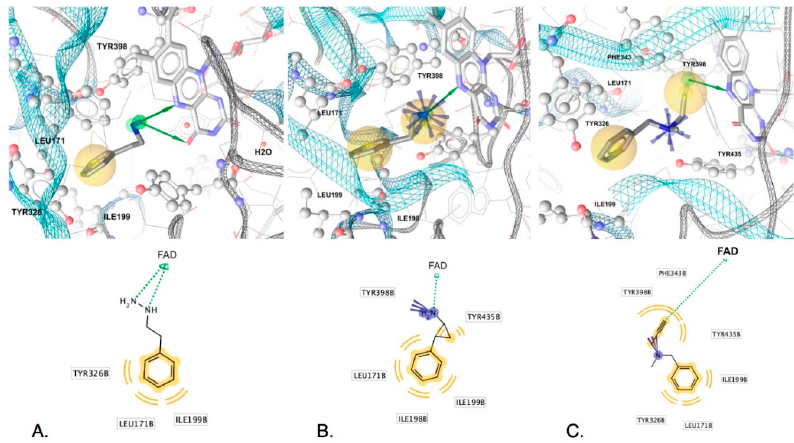
Figure 4. Non-covalent interactions of ( A ) phenelzine, ( B ) tranylcypromine, and ( C ) pargyline in MAO-B (PDB IDs: 2vrm, 2xfu and 1gos). Top images show 3D-interactions in binding sites, and lower ones display 2D-depictions of ligands with features and interaction partners. Hydrogen atoms are not shown. Shown are hydrophobics (yellow spheres), H-bond donors (green arrows), and positive ionizables (blue stars). Interactions were derived using LigandScout 4.4.